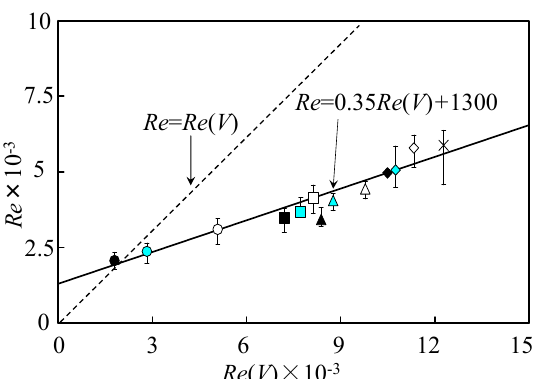
Fig. 15 Reynolds number Re versus Reynolds number Re ( V ) based on a theoretical descent velocity V , for several values of inertia-moment ratio I * at depth-to-width ratio λ = 0.3, aspect ratio AR = 10, C = 3.86 × 10 2 .